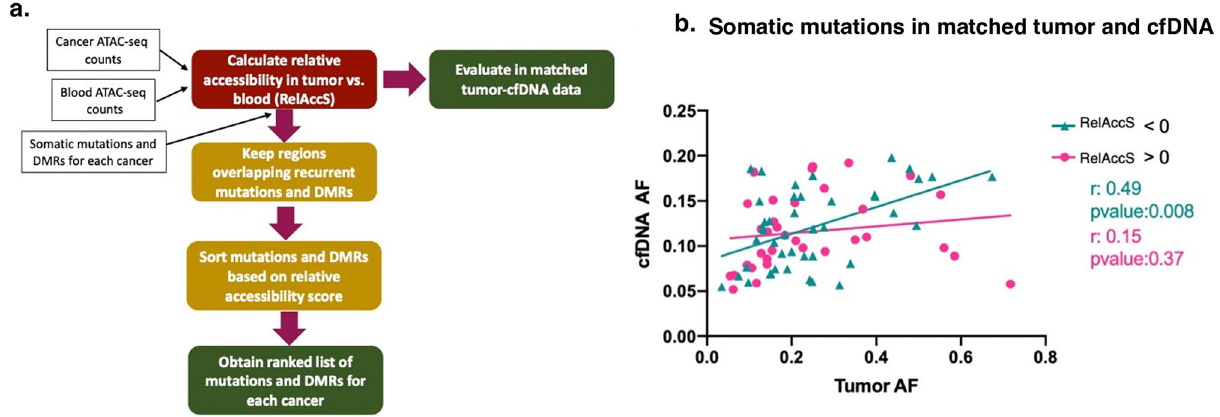
Figure 4. RelAccS score can prioritize markers for inclusion in targeted sequencing panels ( a ). Workflow showing steps for ranking genomic regions harboring cancer markers for inclusion in targeted sequencing panels. Here we ranked cancer specific mutations 43–45 and tDMRs from 2,42 , (Supplementary Data 5). ( b ) Matched tumor and cfDNA targeted sequencing data from 23 prostate cancer patients (obtained from 14 ) were processed to variant calls (“Methods”). For each patient, variants detected in both tumor sample and cfDNA were selected and then divided to two groups based on their corresponding RelAccS score (RelAccS > 0 (pink), RelAccS < 0 (green)). Pearson correlation is shown between allele frequency of variants in tumor (x-axis) and matched cfDNA